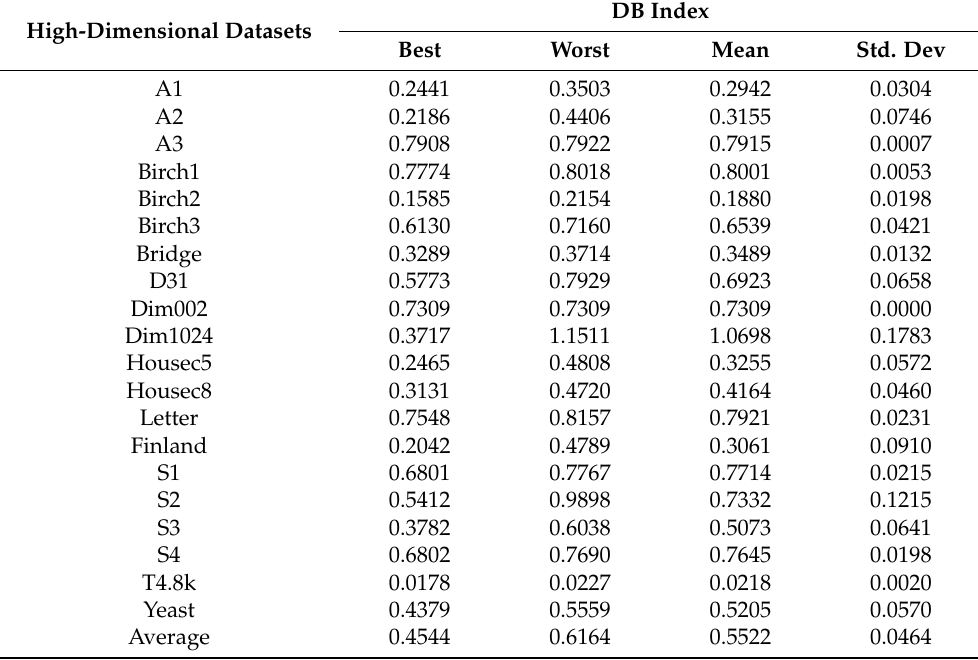
Table 5. Computation result for Improved FA-K-means on twenty high-dimensional